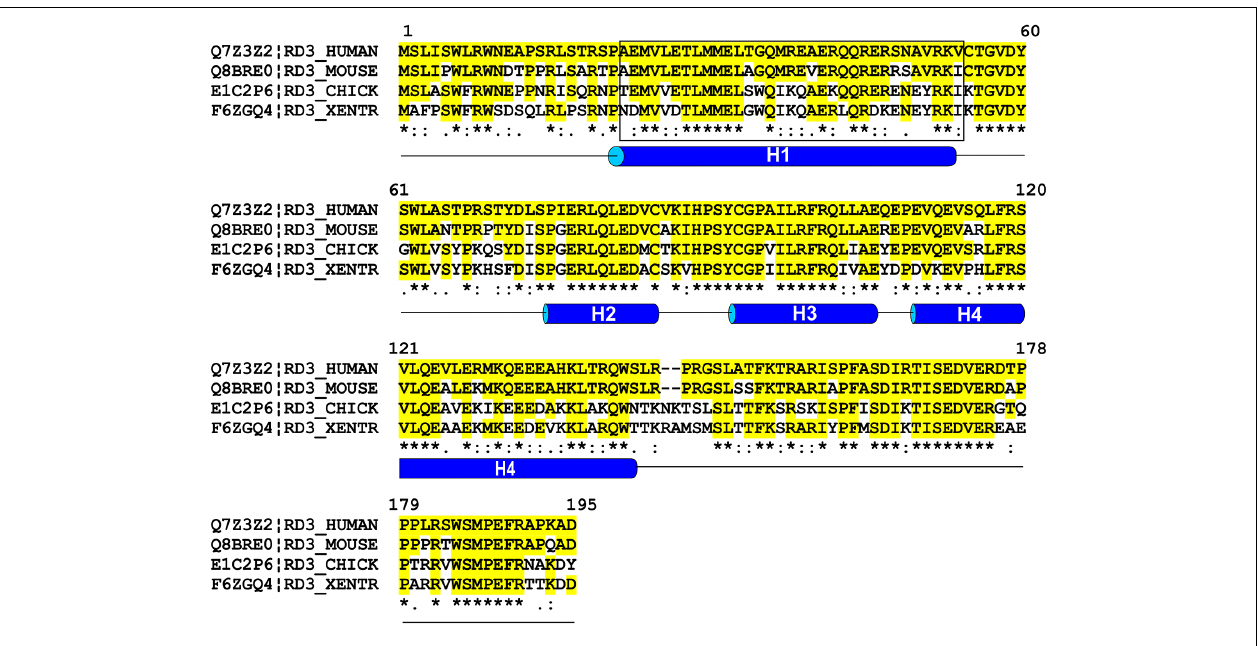
FIGURE 1 | Sequence alignment of RD3 proteins from various vertebrates. Sequences of human, mouse, chick, and Xenopus tropocalis RD3 were aligned using ClustalW multiple alignment program. Sequence identities relative to human RD3 are shown in yellow and * and similarities